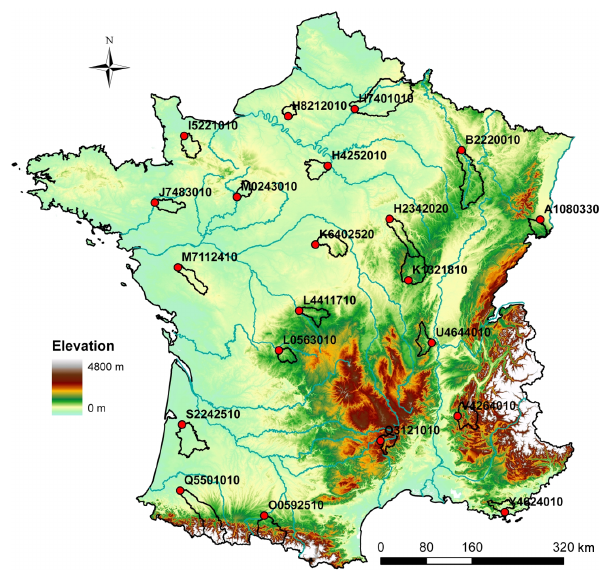
Figure 3. Location of the 21 catchments in France. Red dots repre- sent the catchment